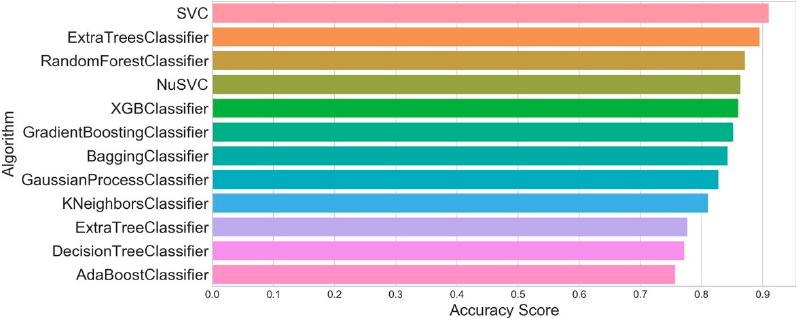
Figure 9. Ranking of ACC scores after model optimization.